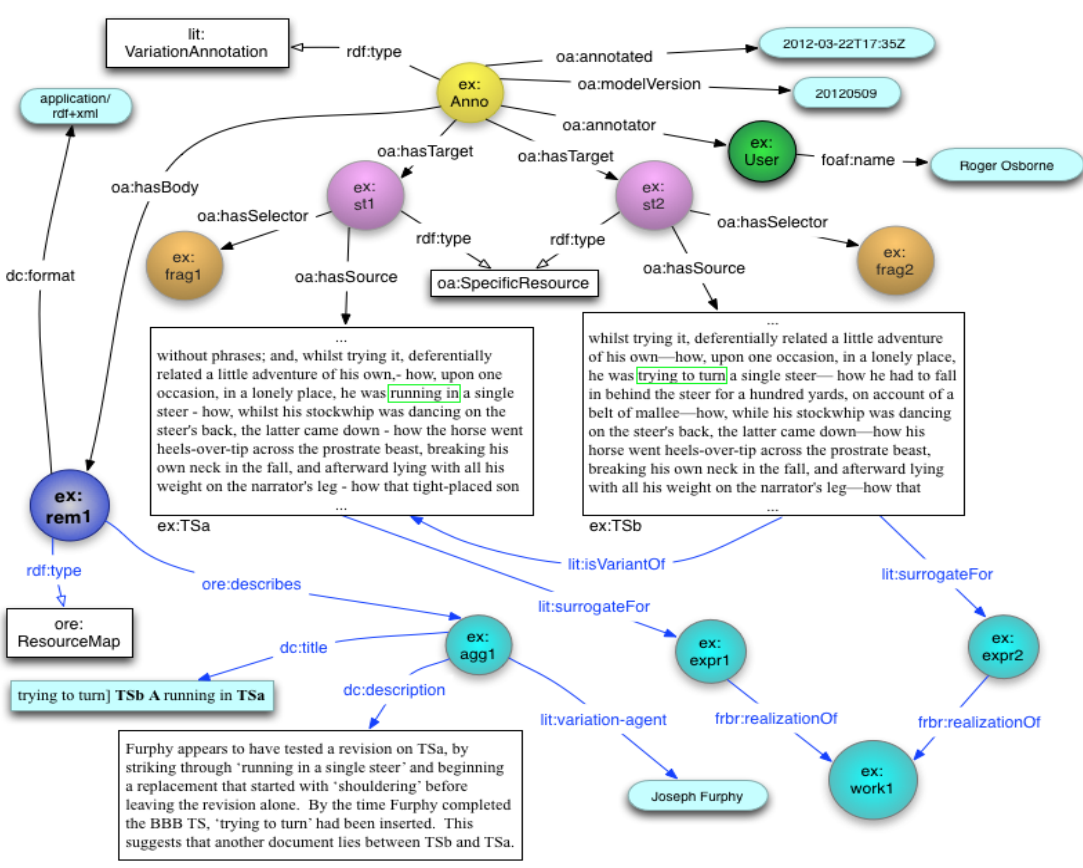
Figure 2. oa: Annotation describing Textual